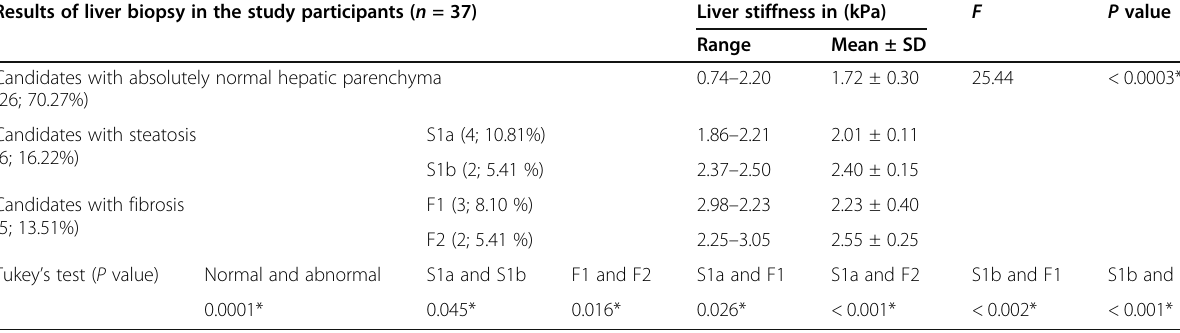
Range Mean ± SD 0.74 – 2.20 < 0.0003*